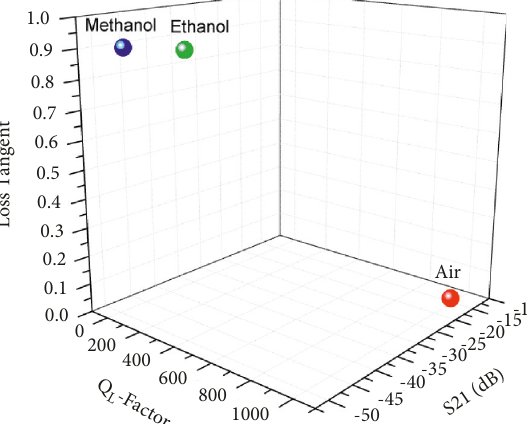
Table 3: Comparison of the stated sensor with lately published outcomes for both ethanol and methanol at 6.1GHz. LUT Ethanol Methanol